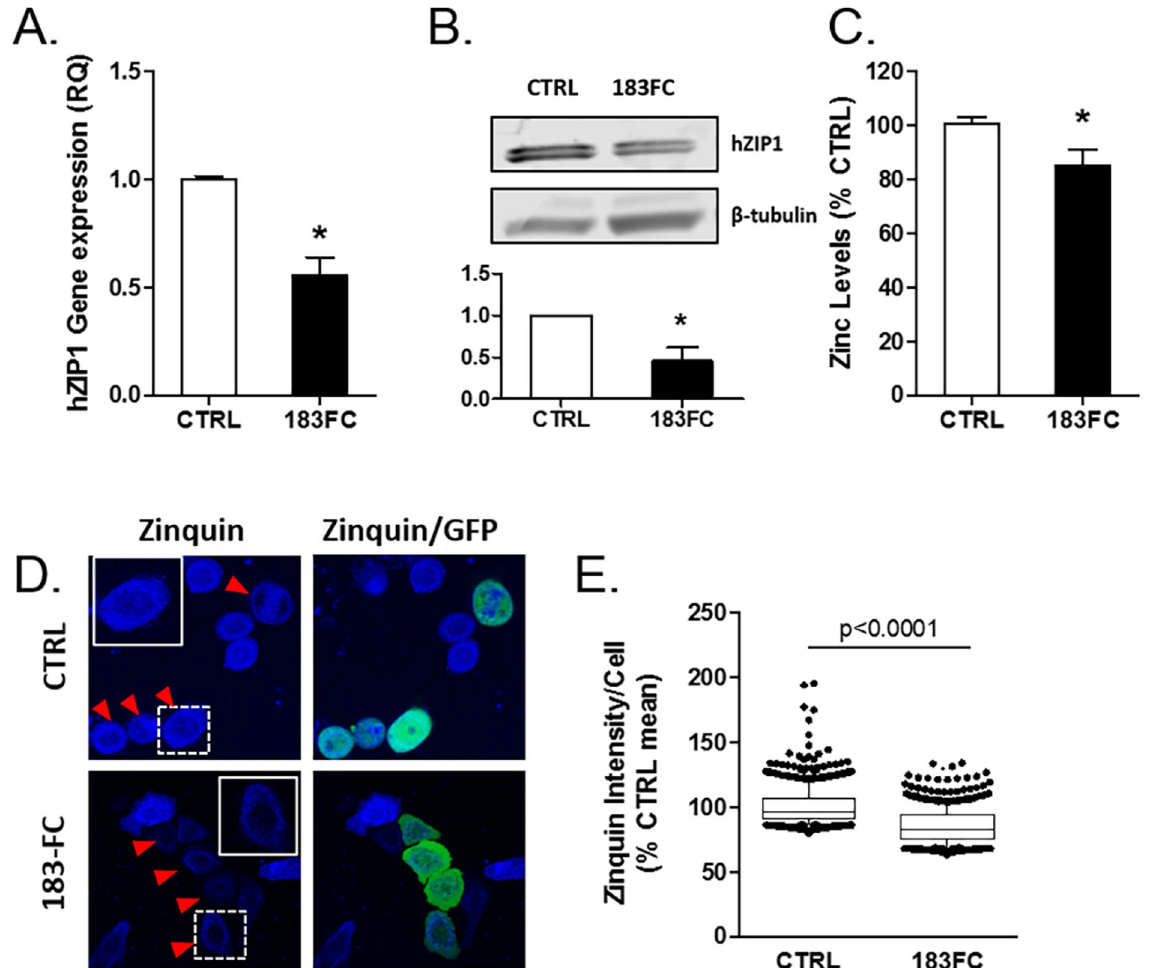
Figure 2. ZIP1 mRNA, hZIP1 protein and zinc levels were lower in miR-183-FC cells. ( A ) hZIP1 mRNA gene expression measured by RT-qPCR in RWPE1-CTRL and RWPE1-183FC cells. ( B ) ZIP1 protein levels measured by immunoblot and quantified. ( C ) Chromogenic zinc assay in RWPE1-CTRL and 183FC cells (n = 3 experiments). Mean shown with SEM. ( D ) Zinquin (blue) fluorescence in RWPE1-CTRL and RWPE1- 183FC cells was imaged with confocal microscopy. Naïve RWPE1 cells were mixed with GFP + cells. Arrows indicate GFP + transduced RWPE1 cells. ( E ) Zinquin intensity quantified per cell by inForm ™ image analysis in RWPE1-CTRL and RWPE1-183FC cells. N = 3 experiments were analyzed as percentage of CTRL mean per experiment. Data from all 3 experiments were analyzed together by Mann-Whitney nonparametric test and are shown as boxplots with mean (line), 25–75% (box) and 95% confidence intervals (whiskers) and individual cell outliers. * p < 0.05 by Mann-Whitney nonparametric test for non-normal distribution of data in parts A and E, Student’s paired 2-sided t-test for parts B and C